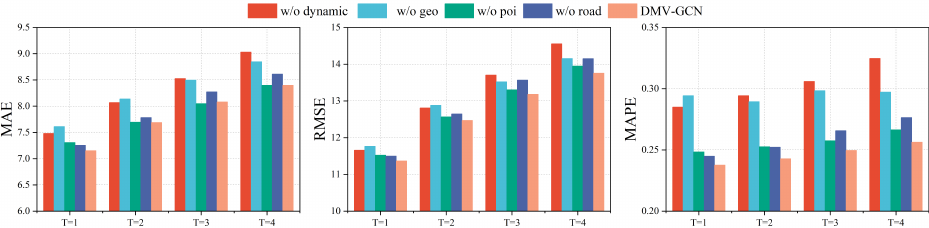
Figure 9. Performance comparison between DMV-GCN and its variant models on NYC-taxi-2016.